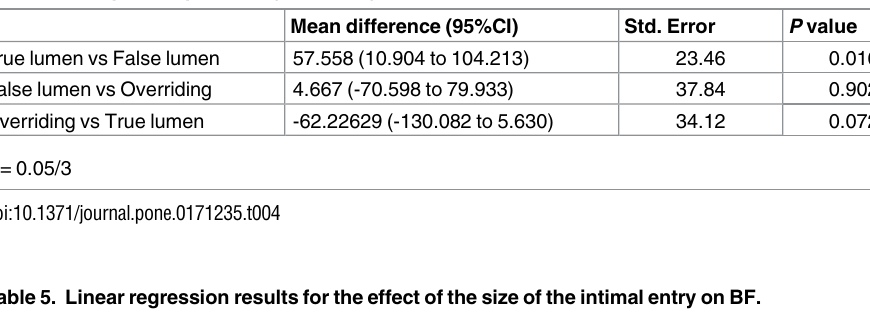
Table 4. Multiple comparisons (LSD-t test).